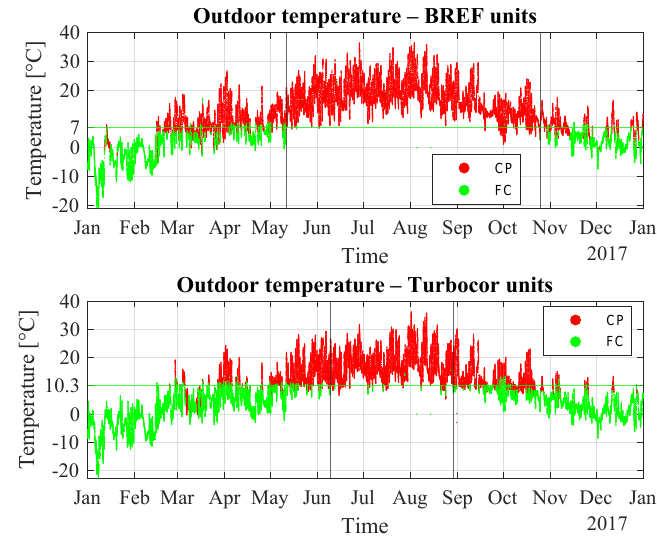
Figure 6. Outdoor